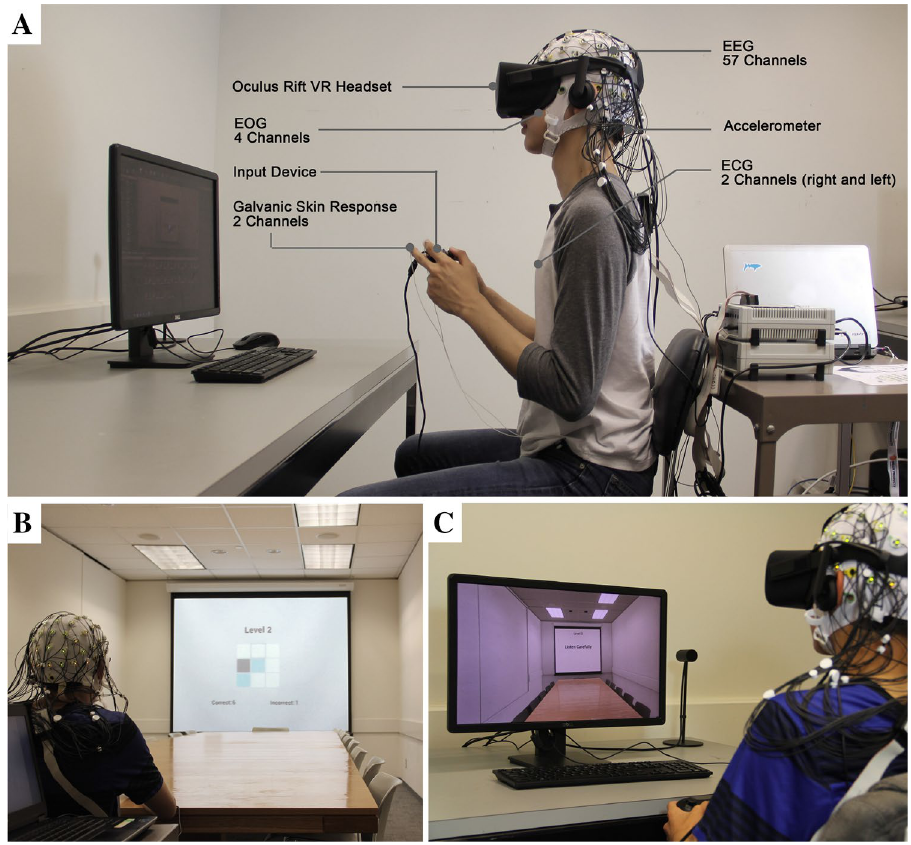
Figure 1. ( A ) Virtual-reality headset along with EEG, EOG, EKG, and GSR sensors, as worn by a study participant. The participants engaged in a series of cognitive tasks in ( B ) . the real classroom and in ( C ) . an identical virtual classroom. The image on the computer screen in ( D ) . shows a two-dimensional capture from the actual immersive 3D experience that is conveyed through the